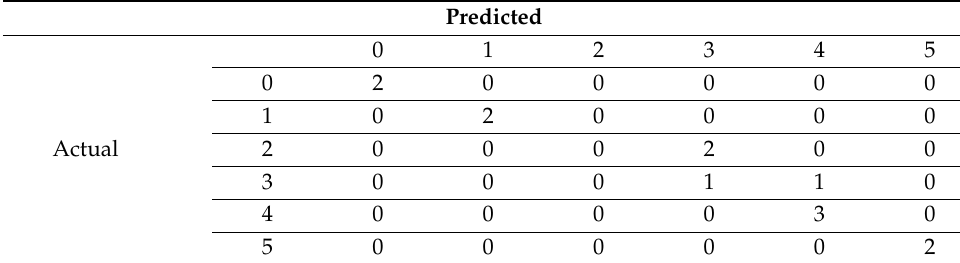
Table 11. KNN with 4 features; Accuracy 76.9%.